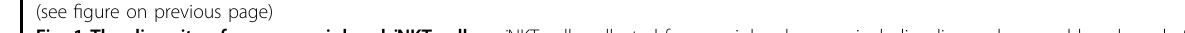
Fig. 1 The diversity of mouse peripheral i NKT cells. a i NKT cells collected from peripheral organs including liver, spleen, and lymph node for scRNA-Seq analysis. b Sorting strategy of i NKT cells from liver, spleen, and lymph node post CD8 + B220 + deletion enrichment. c UMAP plots from 10X genomics scRNA-Seq dataset from sorted peripheral i NKT cells along with thymic different stages of i NKT cells collected. Displaying relationships between i NKT cell organs origins. d UMAP plots of data identical to those in c , but color coded on i NKT cell clusters. e Heatmap of the top ten differentially regulated genes from each cluster derived from d . Each column represents gene expression for an individual cell with color coded on gene expression pro fi les. Yellow is upregulated and purple is downregulated. f Bar graph showing the cell number in each of clusters. g The fractions of ten clusters de fi ned in peripheral i NKT cells. h Pearson correlation matrix of the average expression pro fi les based on all differentially expressed genes from all clusters